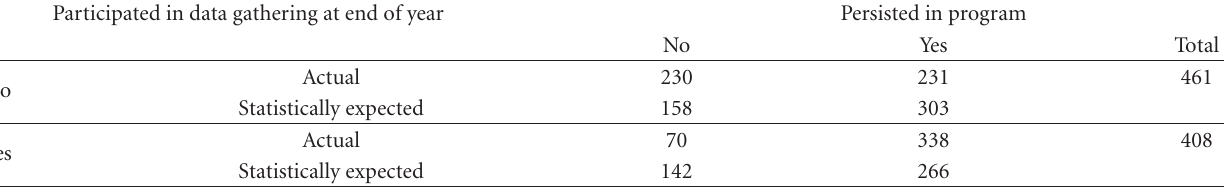
Table 2: Cross tabulation of persistence and participation in data gathering at end of year.